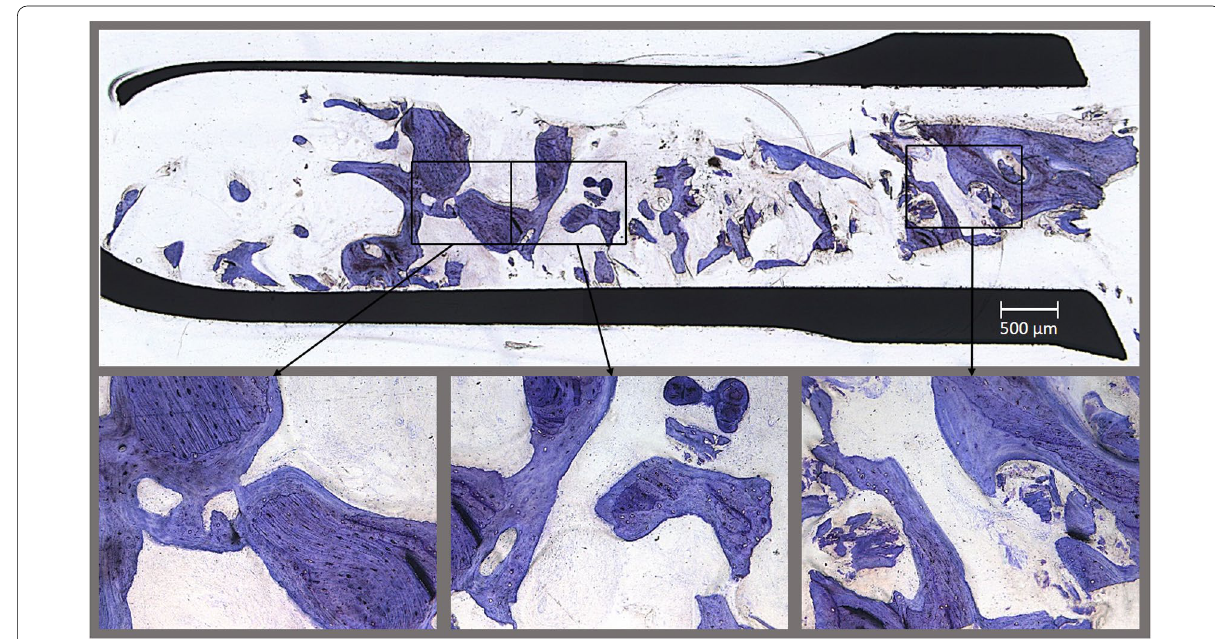
Fig. 7 Toluidine blue staining of a bone biopsy of the upper jaw (still in the trephine bur) gained from a patient treated with enriched bone-marrow aspirate. The lower line shows magnifications of the regenerated bone, the areas are indicated by the black boxes in the